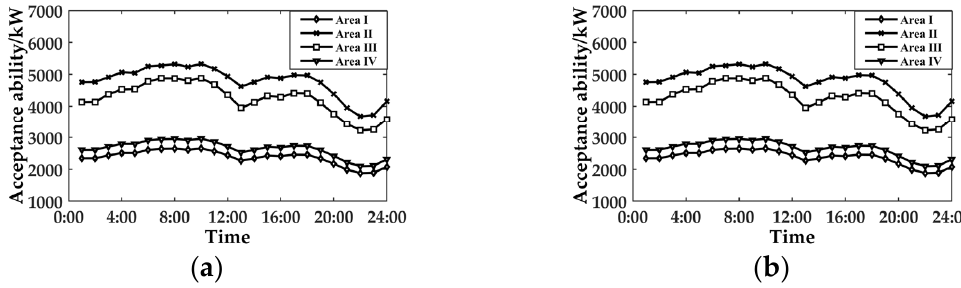
Figure 11. The maximum charging load that can be connected to each partition of the distribution